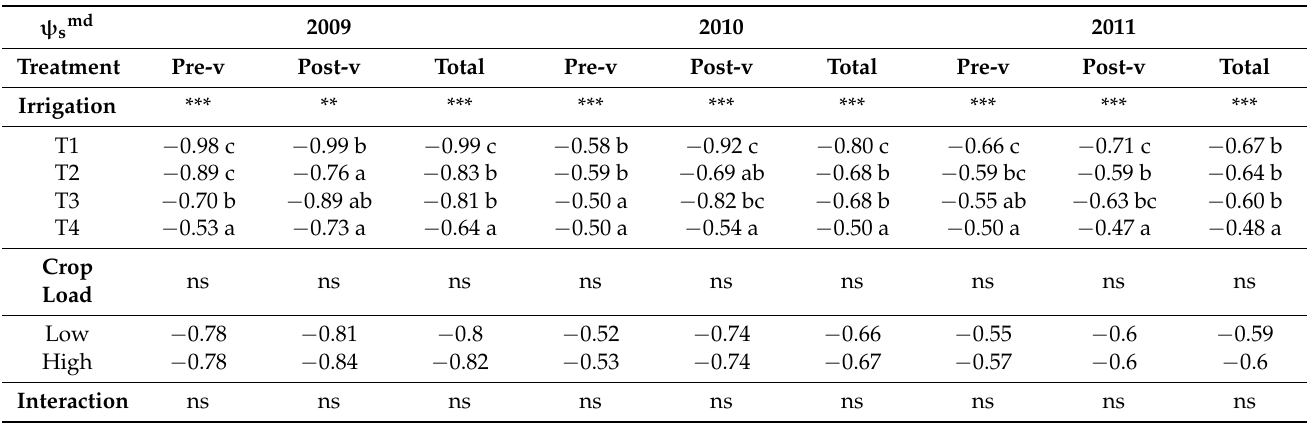
Table 3. Average stem water potential at midday ( ψ smd ) in pre-veraison (Pre-v) and post-veraison (Post-v) periods and in both periods (Total) in the four irrigation treatments and two load levels in the years 2009, 2010, 2011. ψ